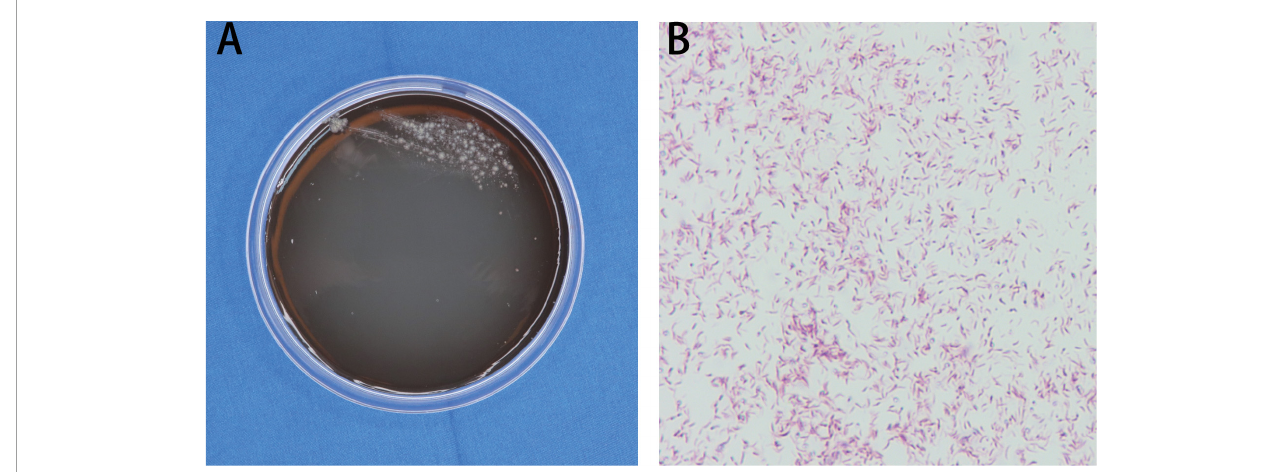
FIGURE4 Mycobacterial strain identification. (A) Morphology of the skin lesion on Middlebrook 7H11 agar. (B) Acid-fast staining showed red and rod-shaped bacteria in branched filaments. Magnification: (B) × 1000.